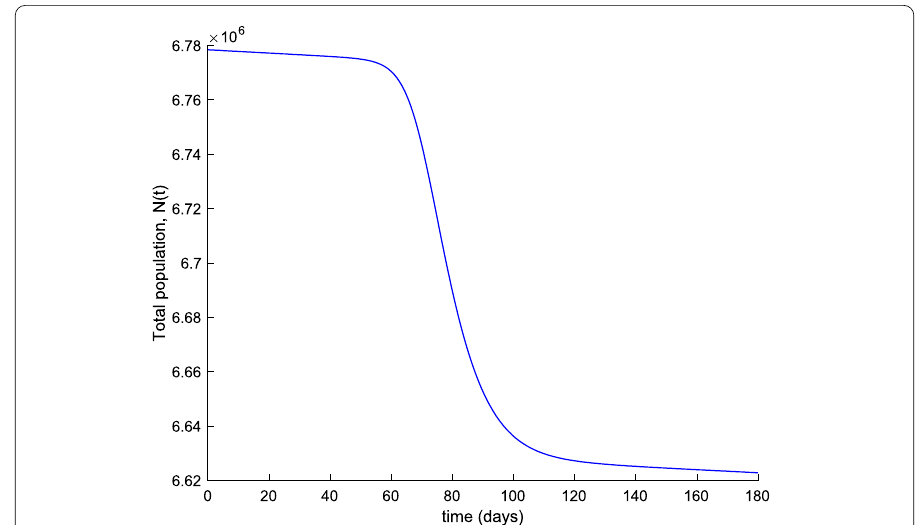
Figure 3 Evolution of the total population in the absence of external actions